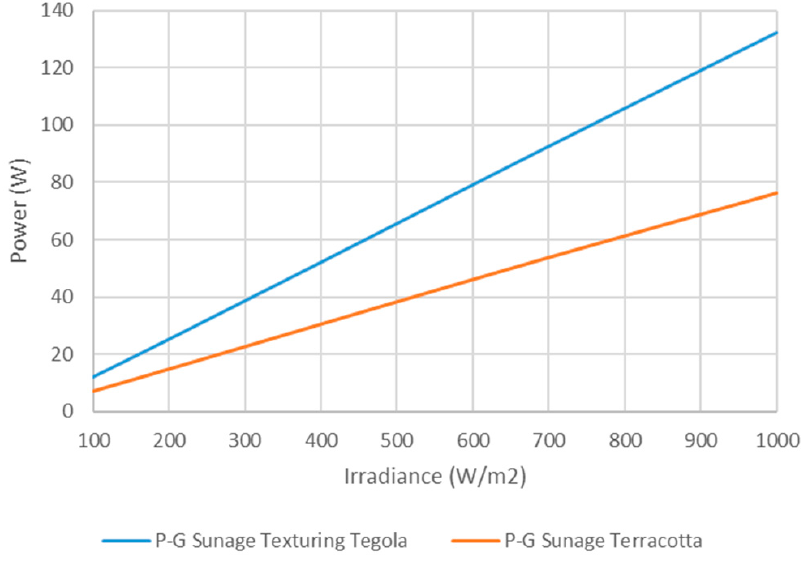
Figure 6. Power at maximum point according to different irradiance levels.